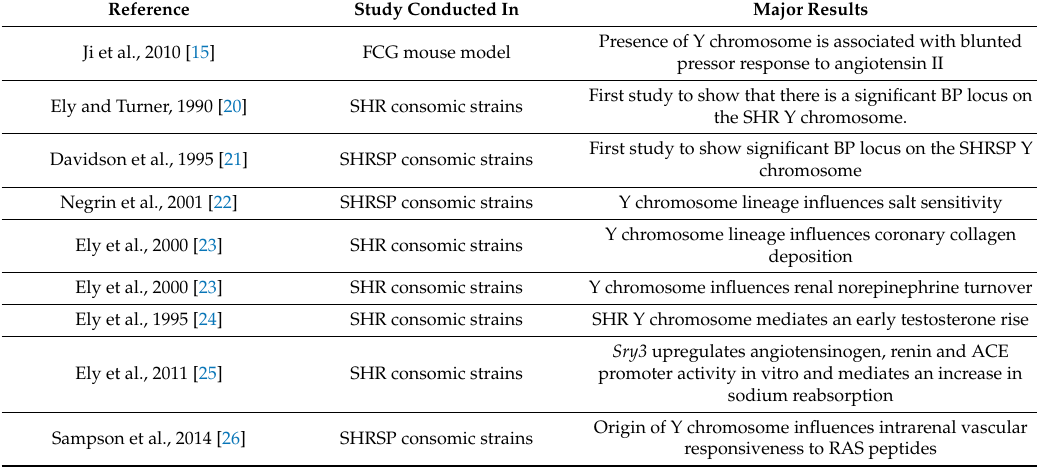
Table 1. Summary of rodent studies on Y chromosome lineage and cardiovascular